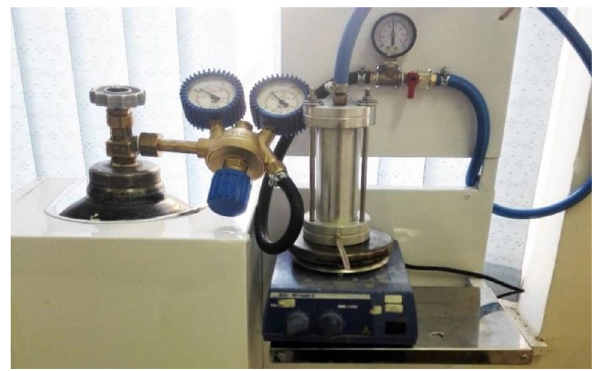
Fig. 1 The image of the applied membrane